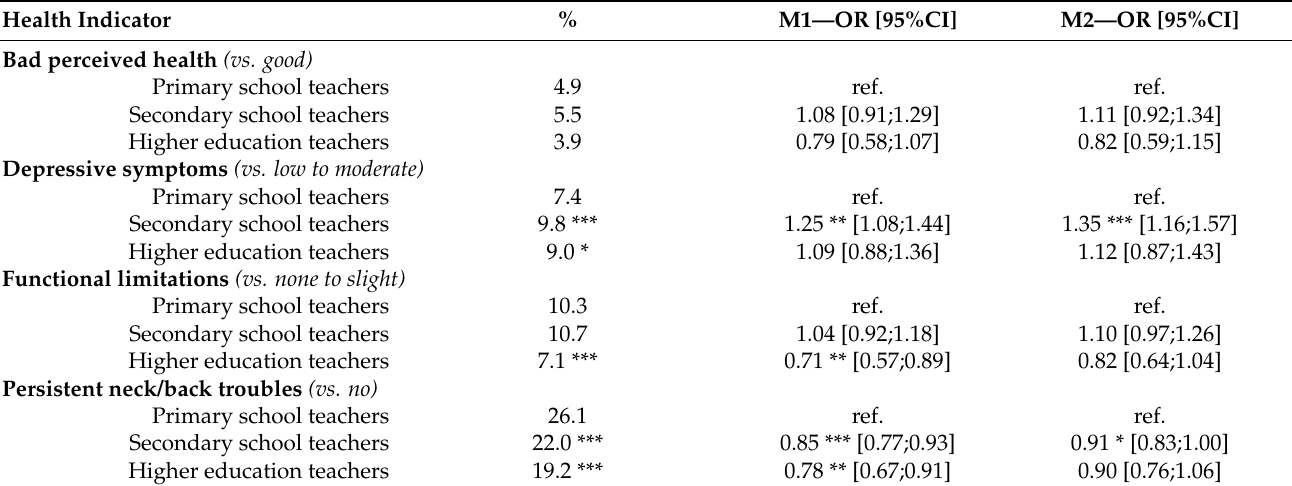
Table 3. Health indicators of teachers according to their teaching level, basic and further adjustment, ESTER-CONSTANCES